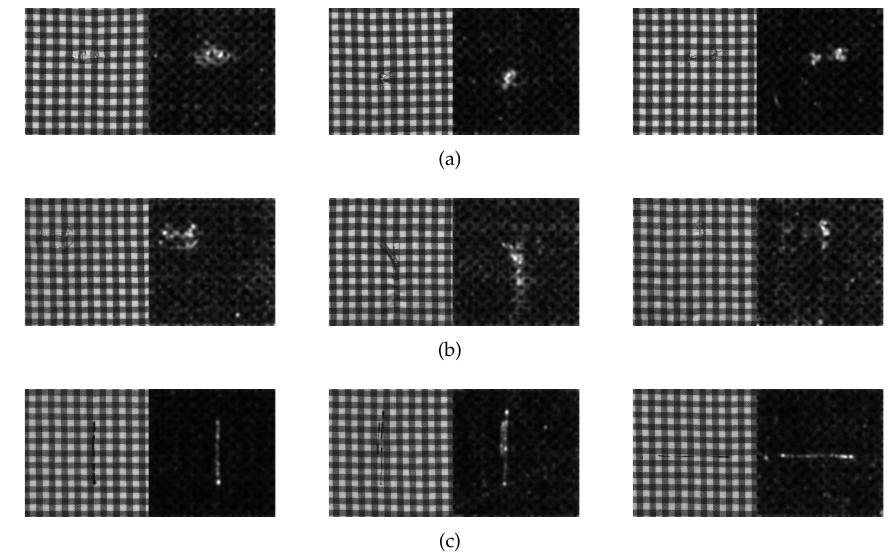
Figure 11. Saliency map of box-patterned fabric defect detection. ( a ) hole type; ( b ) netting multiple type; ( c ) thin bar type.